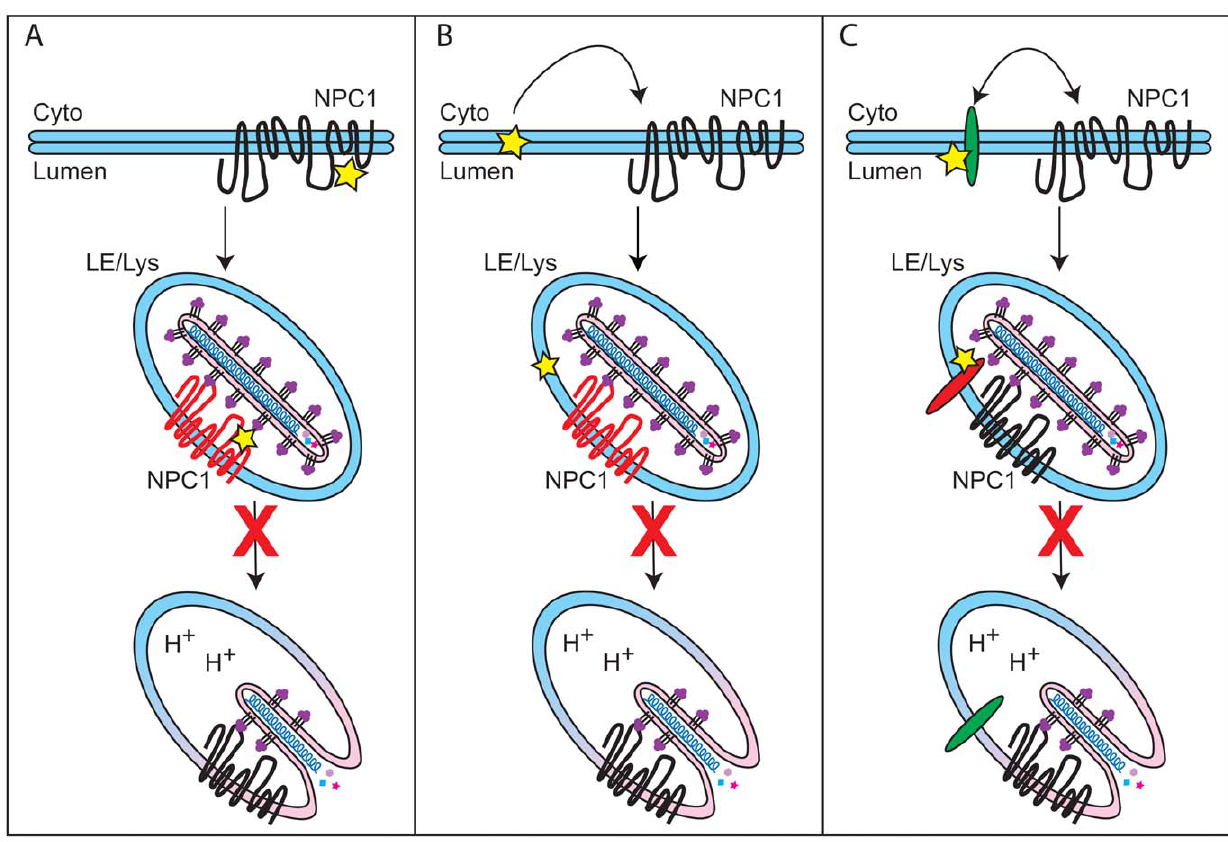
Figure 8. Models for how CADs May Block EBOV Entry. (A) In the first model, the CADs (yellow star) interact directly with NPC1, but at a site distinct from the C loop of NPC1 (which binds GP 19 kDa ). Binding to NPC1 inhibits a second function of NPC1 (i.e. in addition to its role in binding GP 19 kDa ) that is critical for EBOV entry. (B) In the second model, the CADs intercalate into the LE/Lys membrane, indirectly inhibiting a second function of NPC1 that promotes EBOV entry. (C) In a final model, the CADs disrupt a target distinct from NPC1 that is critical for EBOV fusion with LE/ Lys) and is regulated by NPC1. The target may be another LE/Lys protein (e.g. ASM) or a lipid of the LE/Lys membrane system. (See text for details.) Alternatively, the CADs may interfere with NPC1-dependent membrane trafficking [47,50] such that the virus is never found in an NPC1-containing compartment. In all of the models, the yellow star denotes a CAD and red in each middle image denotes the target molecule.